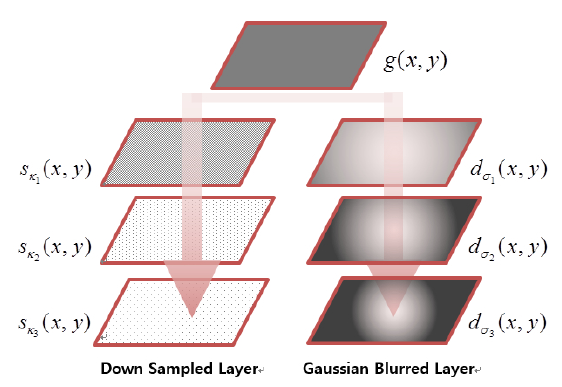
Figure 6. The hierarchical structure of down-sampling and difference of Gaussian